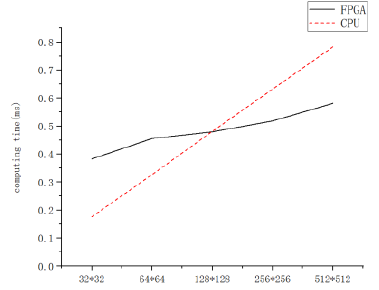
Fig. 7. Comparison of FGPA and CPU computing time of radix-2 decimation-in-time